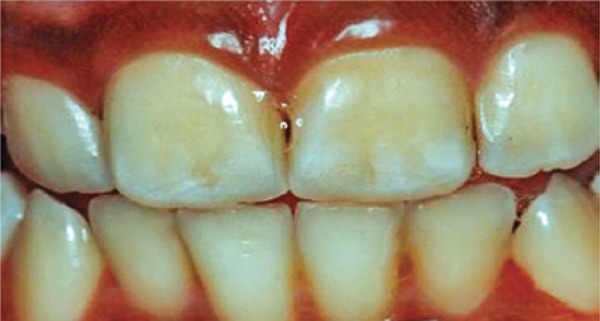
Dentes com fluorose leve